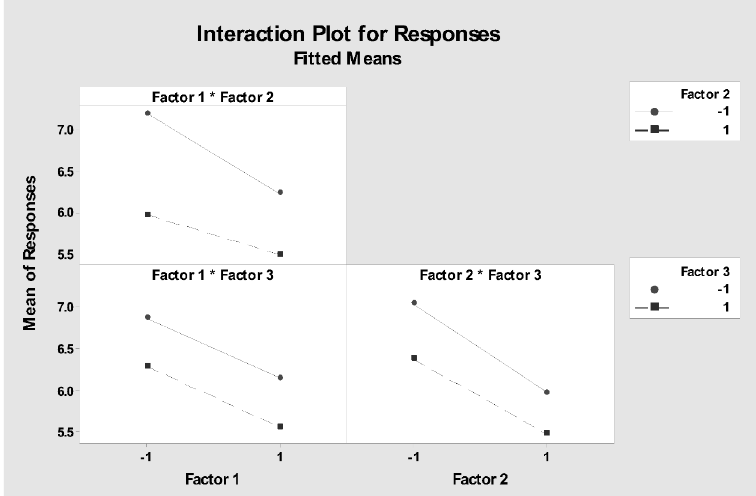
Figure 1 : Interaction effect of factors